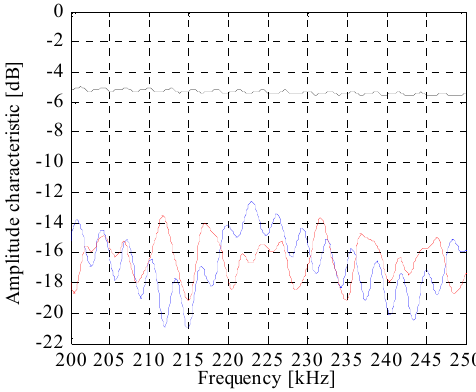
Figure 14. Amplitude characteristics of the faulted power line for broken middle phase conductor. The middle phase to the outer phase coupling. Legend: blue-5 km fault distance, red-30 km fault distance, black-normal.